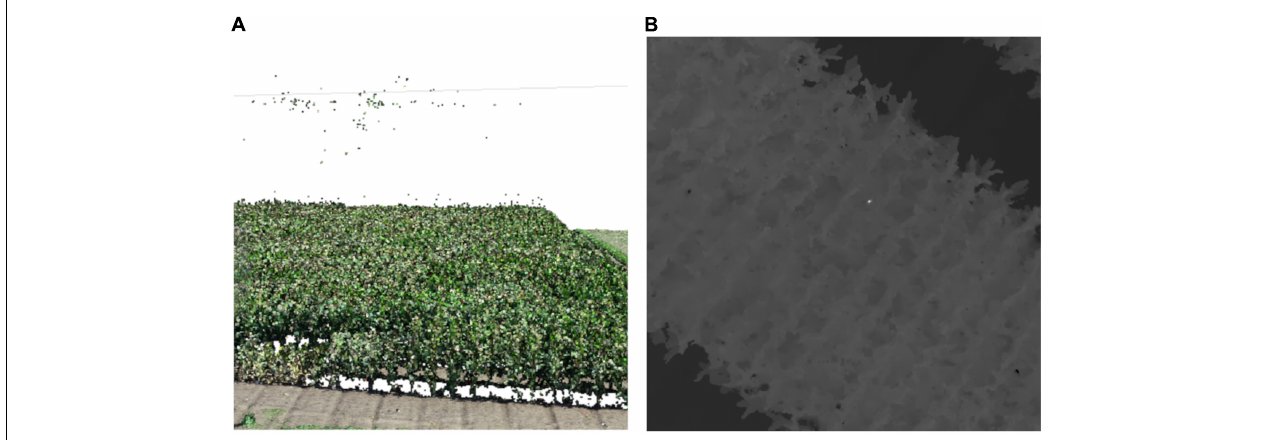
FIGURE 4 | An example of noises in point clouds. (A) A point cloud with noises (some points floating over plants). (B) A DSM with noises (an extremely high area near the center). The DSM is shown in grayscale; when the pixel is white, the altitude is high.